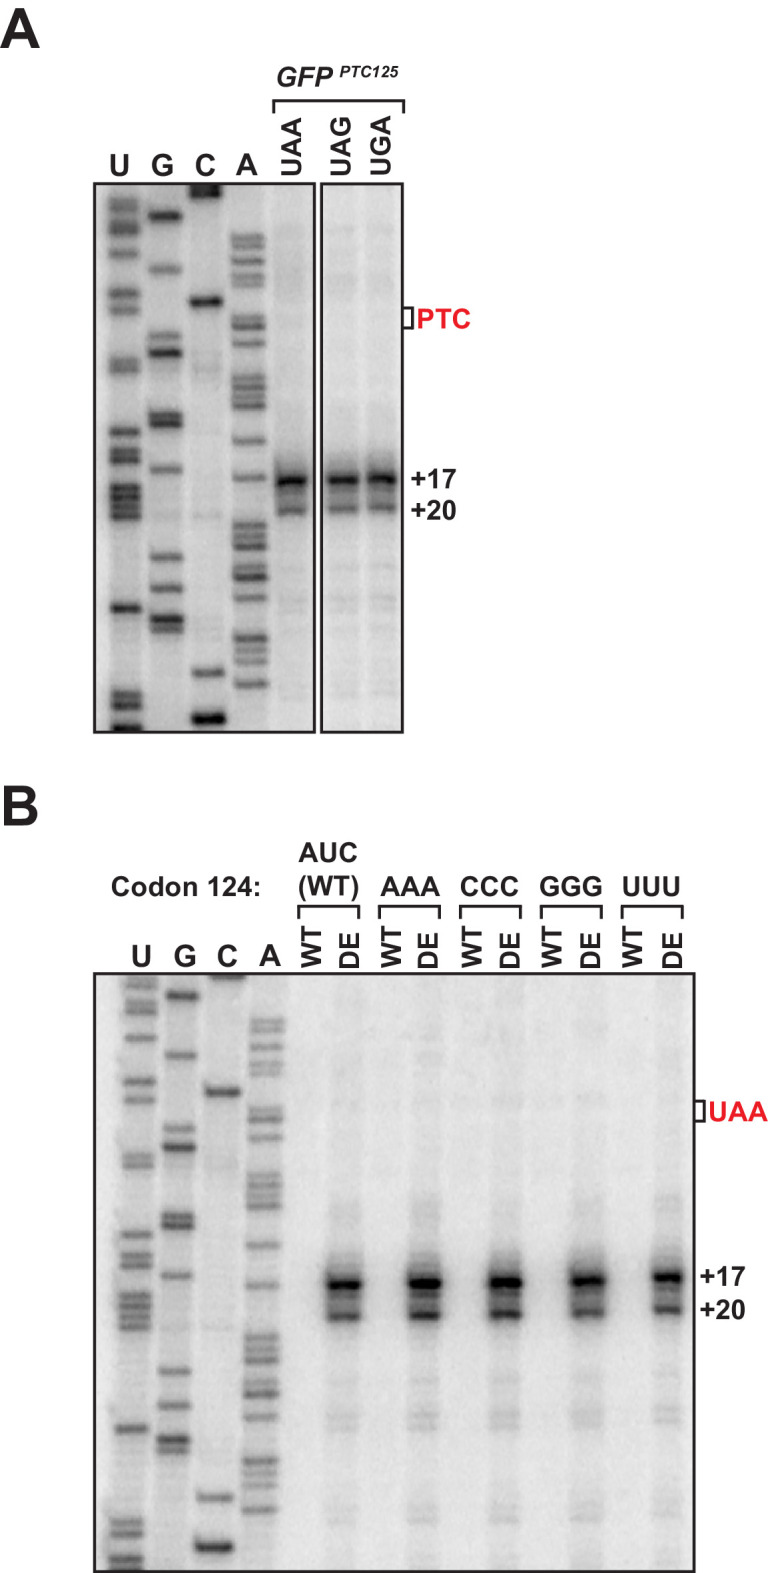
Accumulation of 3’ RNA decay intermediates in UPF1 ATPase mutants is unaffected by the nucleotide sequence of the PTC or penultimate sense codon.(A) Primer extension analysis of GFPPTC125 mRNA harboring a UAA, UAG, or UGA nonsense codon from ATPase-deficient UPF1 mutants. (B) Primer extension analysis of GFPPTC125 mRNA with mutations within GFP codon 124 as indicated.